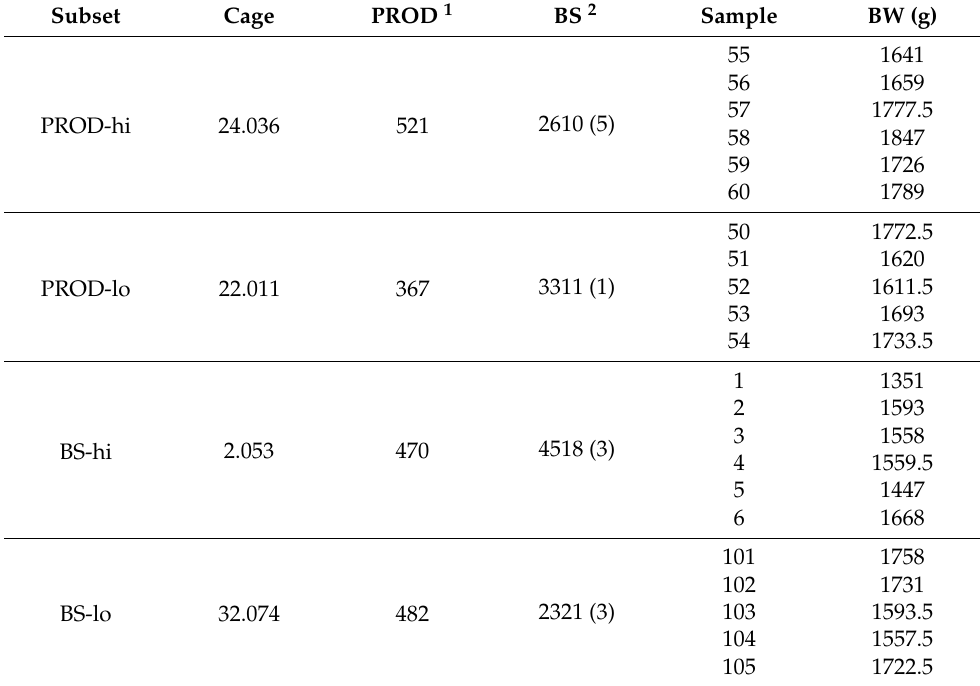
Table 3. Cage performance data and individual hen body weight of the four cages selected on the basis of high vs. low PROD and BS,